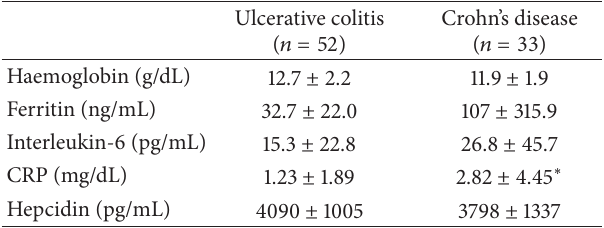
Table 2: Comparison of anaemia parameters, hepcidin levels, and inflammatory markers between patients with ulcerative colitis and Crohn’s